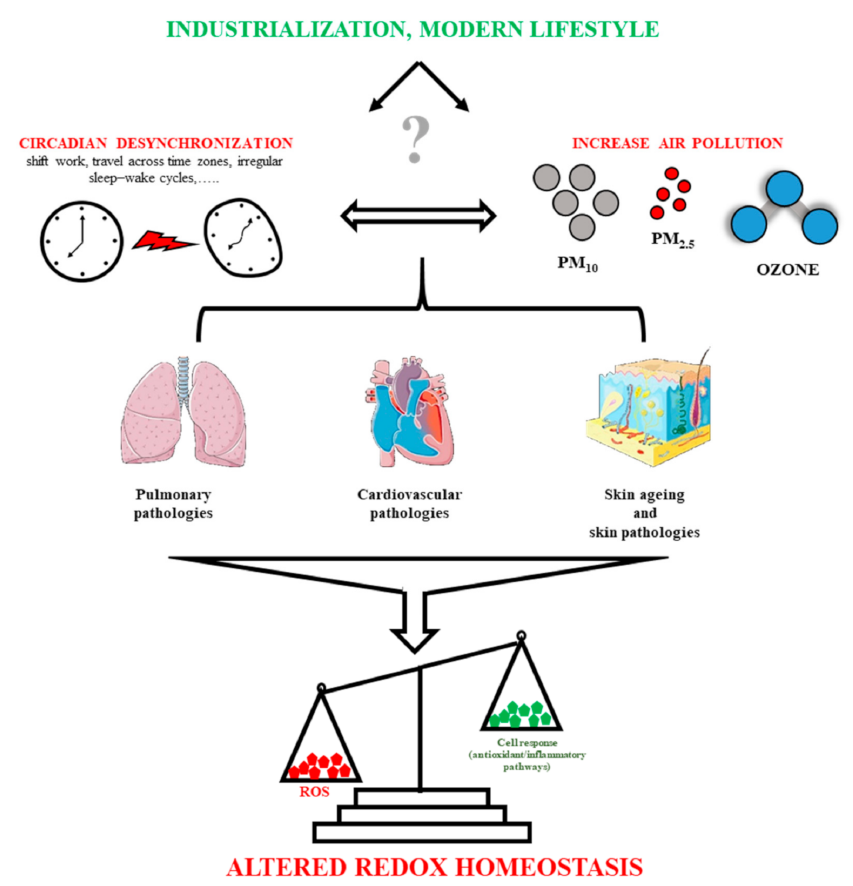
Figure 1. Schematic summary of the conclusion section. In this review, we summarize the negative impact of the environmental stressors (in particular, ozone and particulate matters) and desynchro- nization of the circadian system on pulmonary, cardiovascular and cutaneous systems. We hypothe- size that circadian misalignment can exacerbate cell susceptibility to airborne pollutants, reducing the efficiency of the antioxidant defense system, and worsening the state of